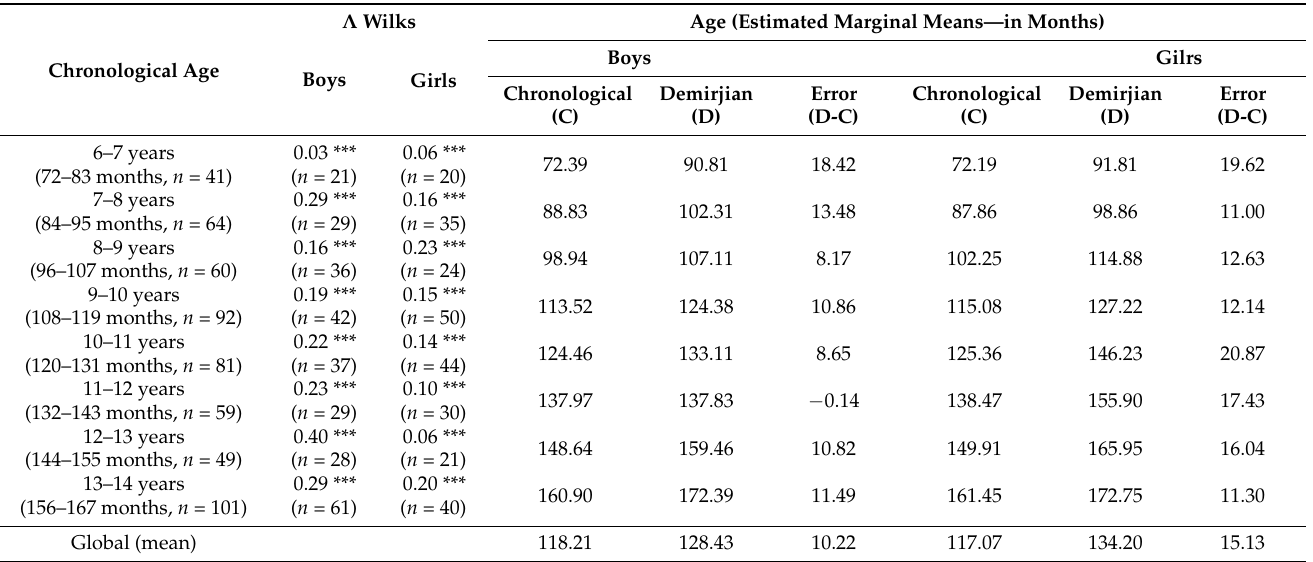
Table 4. Λ Wilks and estimated marginal means of age (chronological and estimated by the Demirjian scores) for boys and girls according to age group.